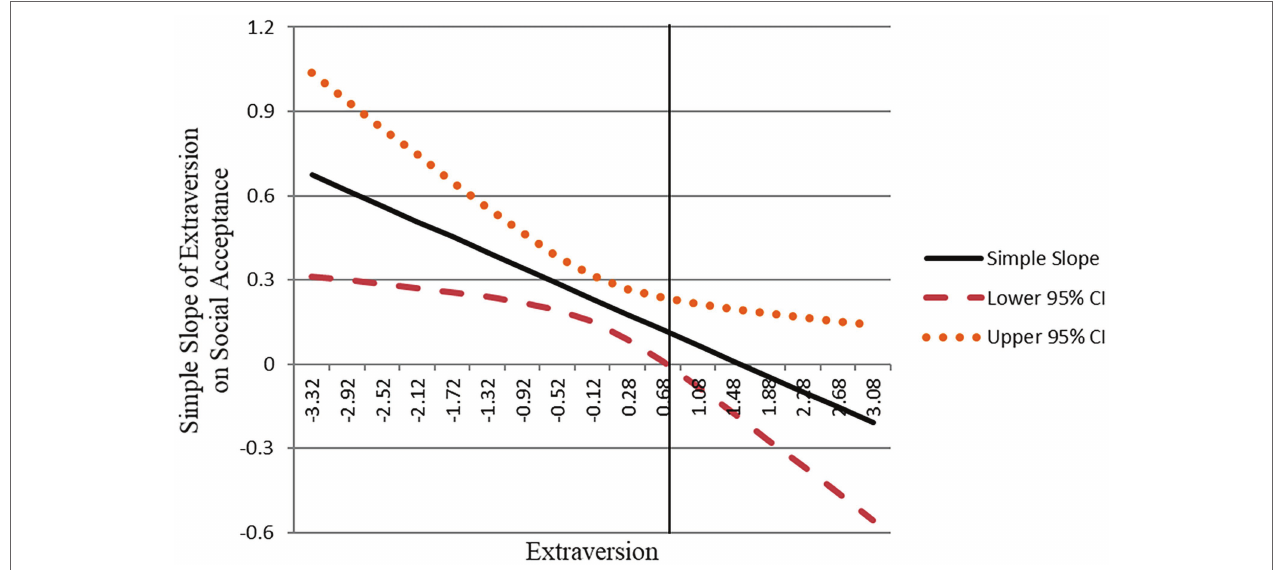
FIGURE 2 | Johnson–Neyman (J–N) plot of the region of significance for the simple slope of extraversion on social acceptance.